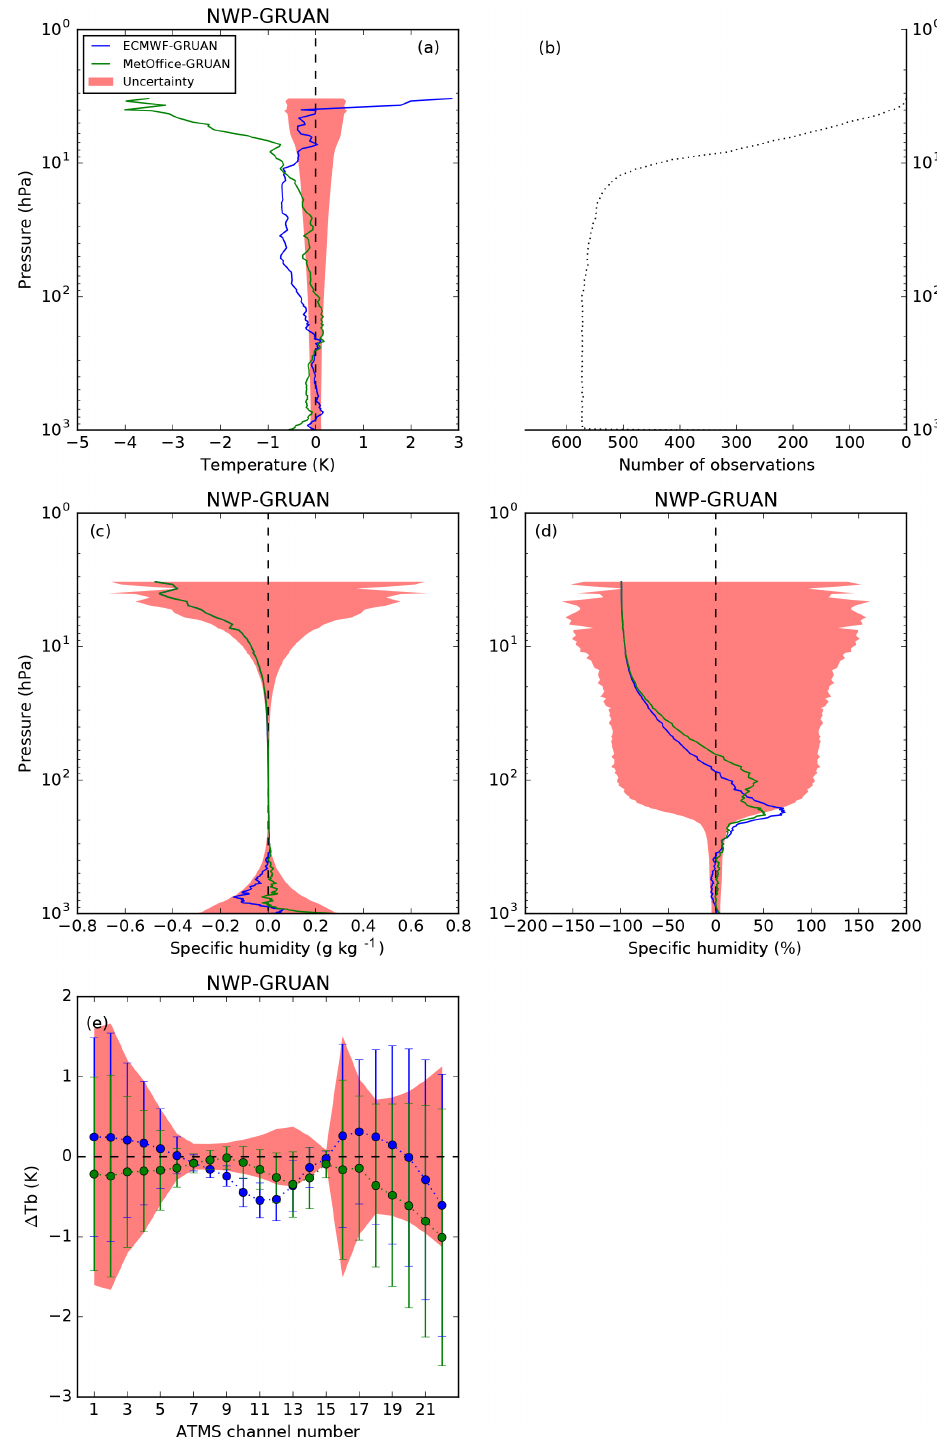
Figure 4. Mean difference ECMWF–GRUAN (blue) and Met Office–GRUAN (green) calculated from 573 daytime collocations from Lin- denberg in 2016. The temperature difference (a) is expressed in kelvin, the humidity difference is expressed in grams per kilogram (c) and in percentage ( NWP − GRUAN / GRUAN ) (d) , and the difference in simulated brightness temperatures for the 22 ATMS channels is expressed in kelvin (e) with the 1 σ standard deviation (vertical bars). The red shading shows GRUAN uncertainty. The number of observations is shown as a function of the pressure (b)